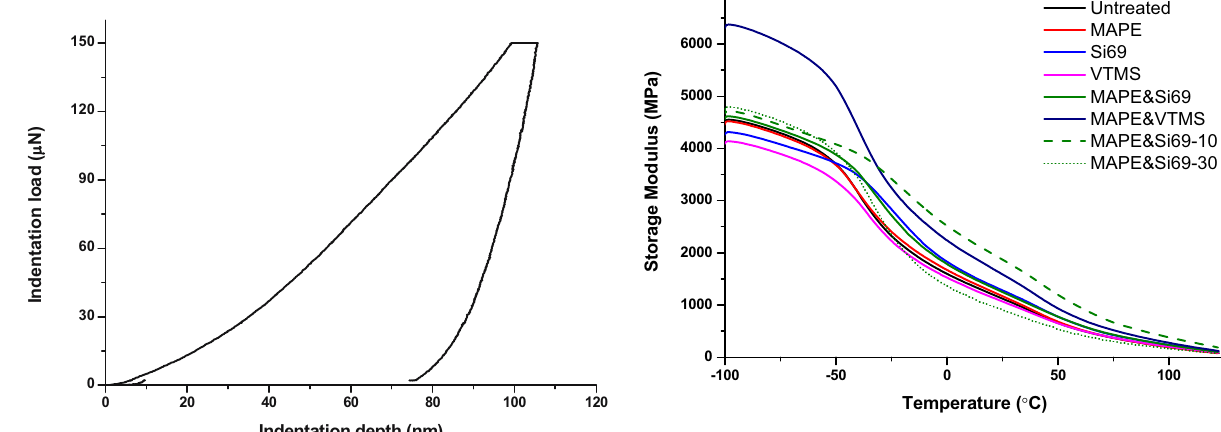
Figure 4: Storage modulus of untreated and coupling agent treated RubWPC as a function of